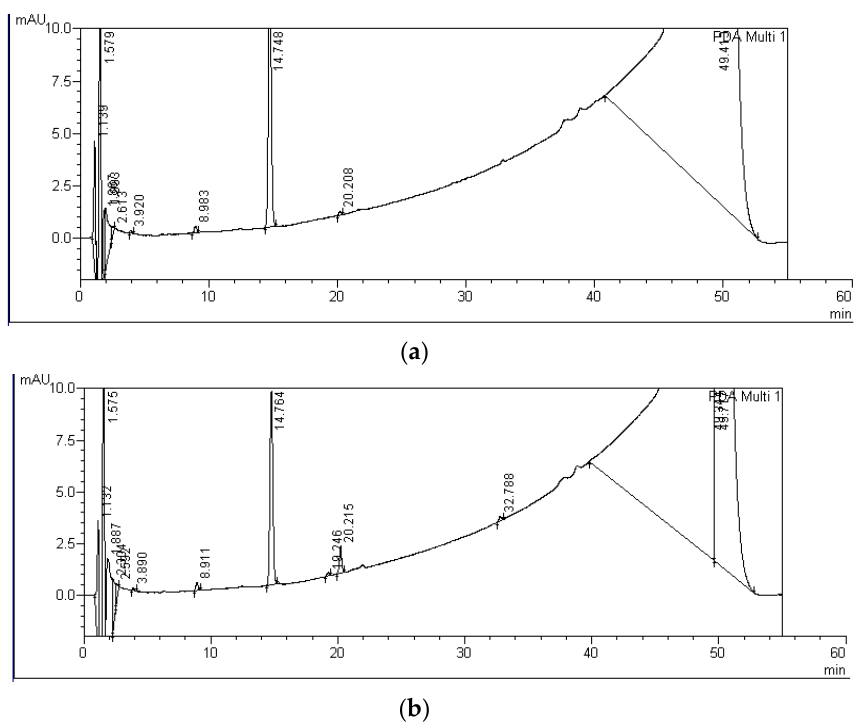
Figure 5. HPLC chromatograms indicating the progressive reduction peaks relevant to MC-LR and growing peaks of MC-LR degradation products after four ( a ) and nine days ( b ) of incubation with S. polyrhiza and associated microorganisms. Peaks and their retention times for MC-LR and its degradation products were as follows: MC-LR — 14.748 – 14.764 min.; A-LR — 19.246 min. and B-LR — 20.215 – 20.208 min.